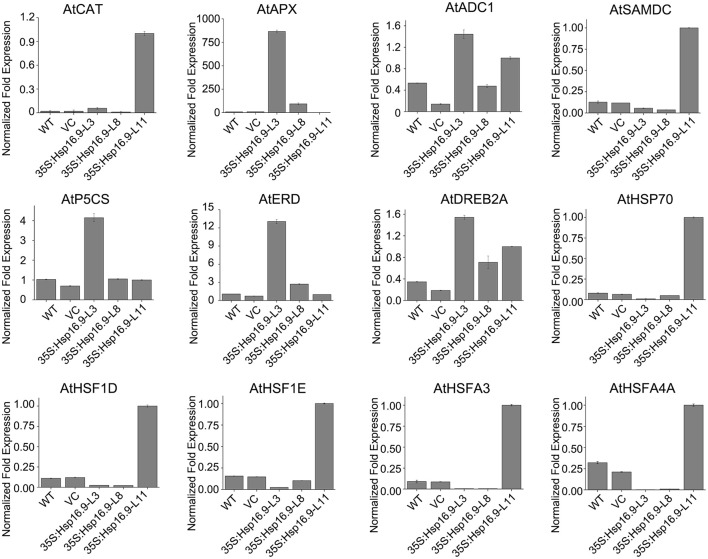
Expression profiles of genes related to MsHsp16.9.